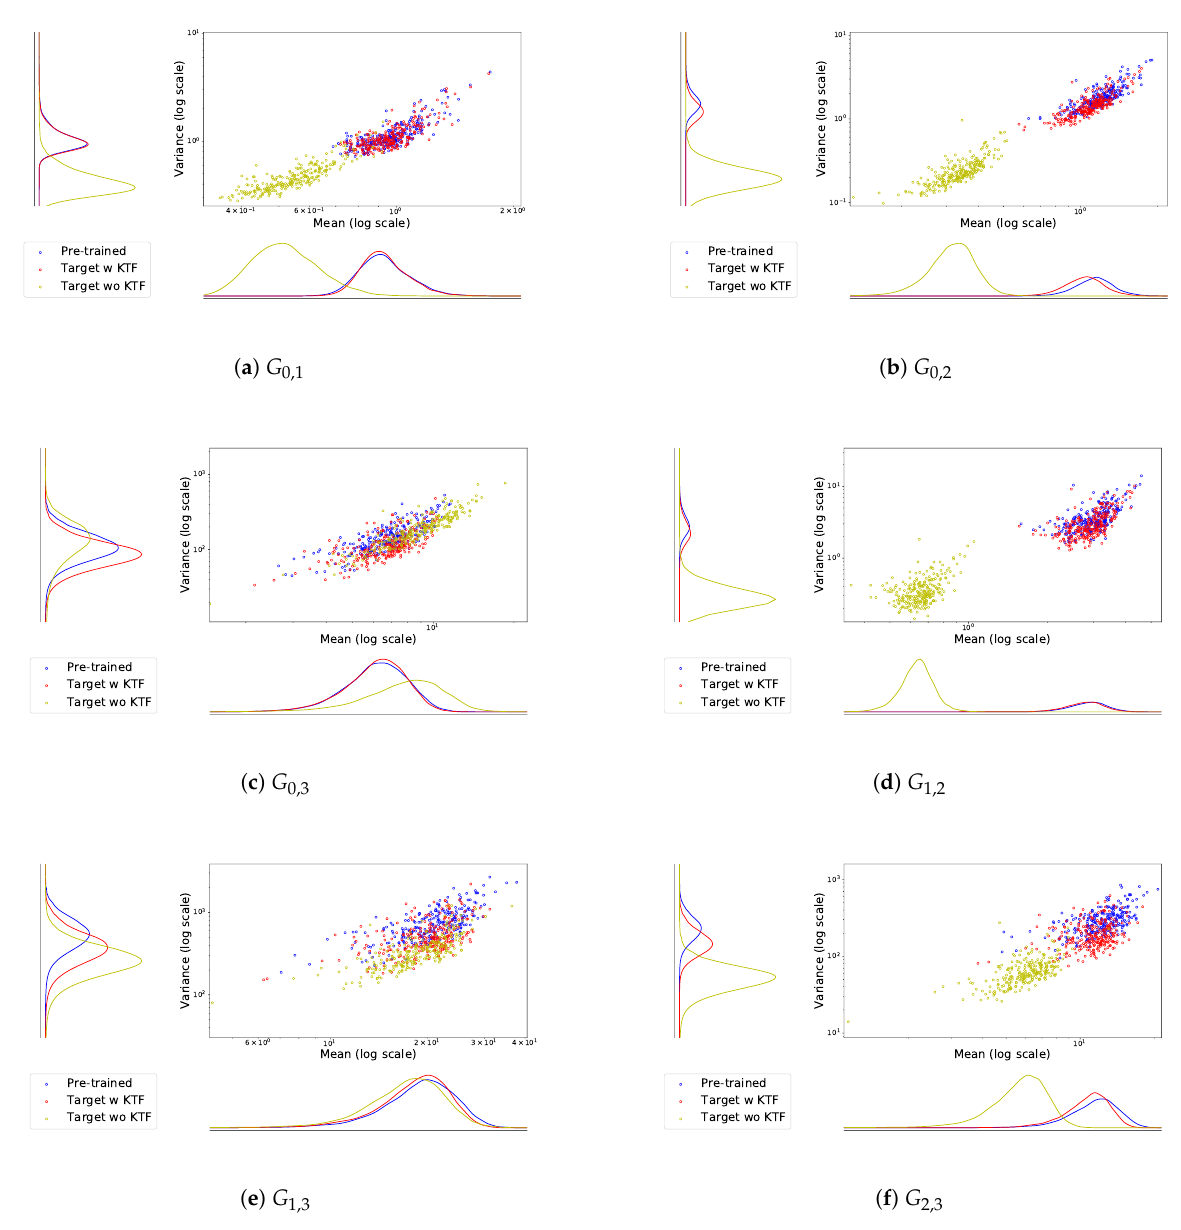
Figure 3. Distributions of FSP matrices for the 32-layer pre-trained, 8-layer target, and original 8-layer ResNets without knowledge. In this figure, the blue, red, and yellow points denote the mean and variables of the FSP matrices for the pre-trained, target, and original ResNets,